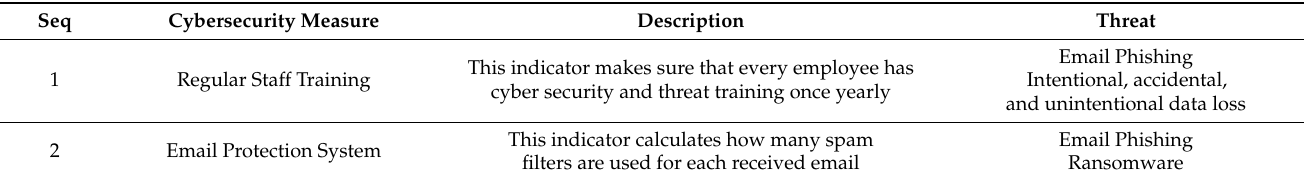
Table 1. Summary of the measures taken by hospitals to improve